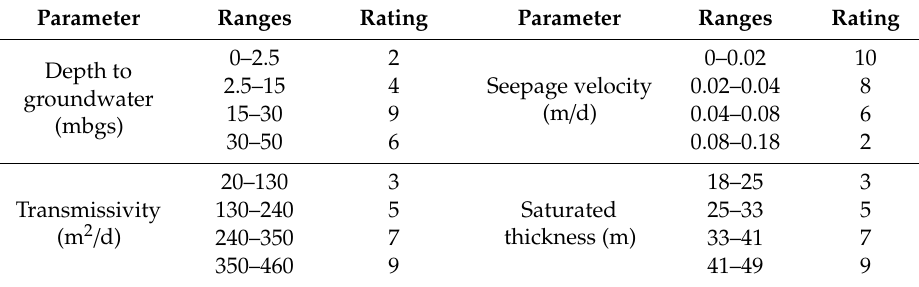
Table 5. Parameters ranging and rating for Babylon